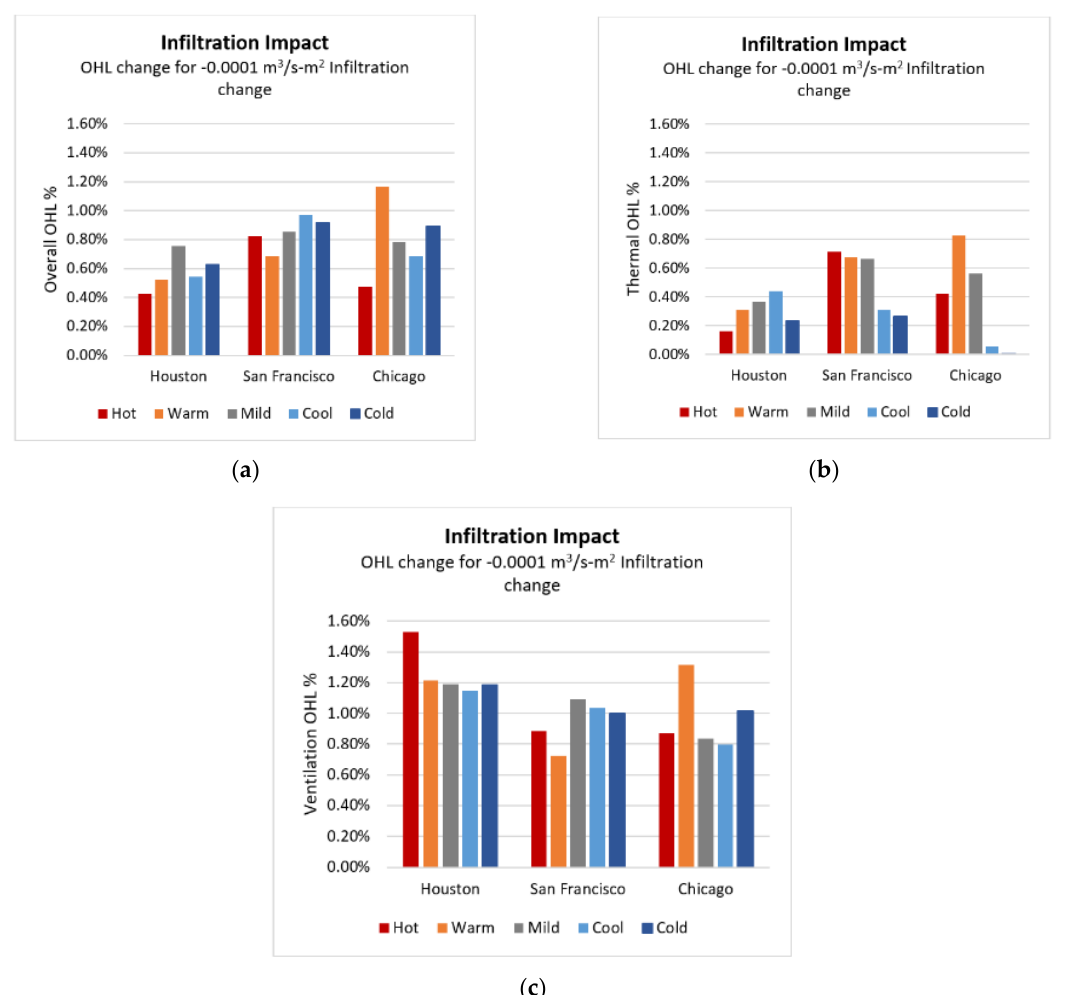
Figure 15. Impact of a 0.1 decrease in glazing visible transmittance on overall ( a ) and visual ( b ) OHL.